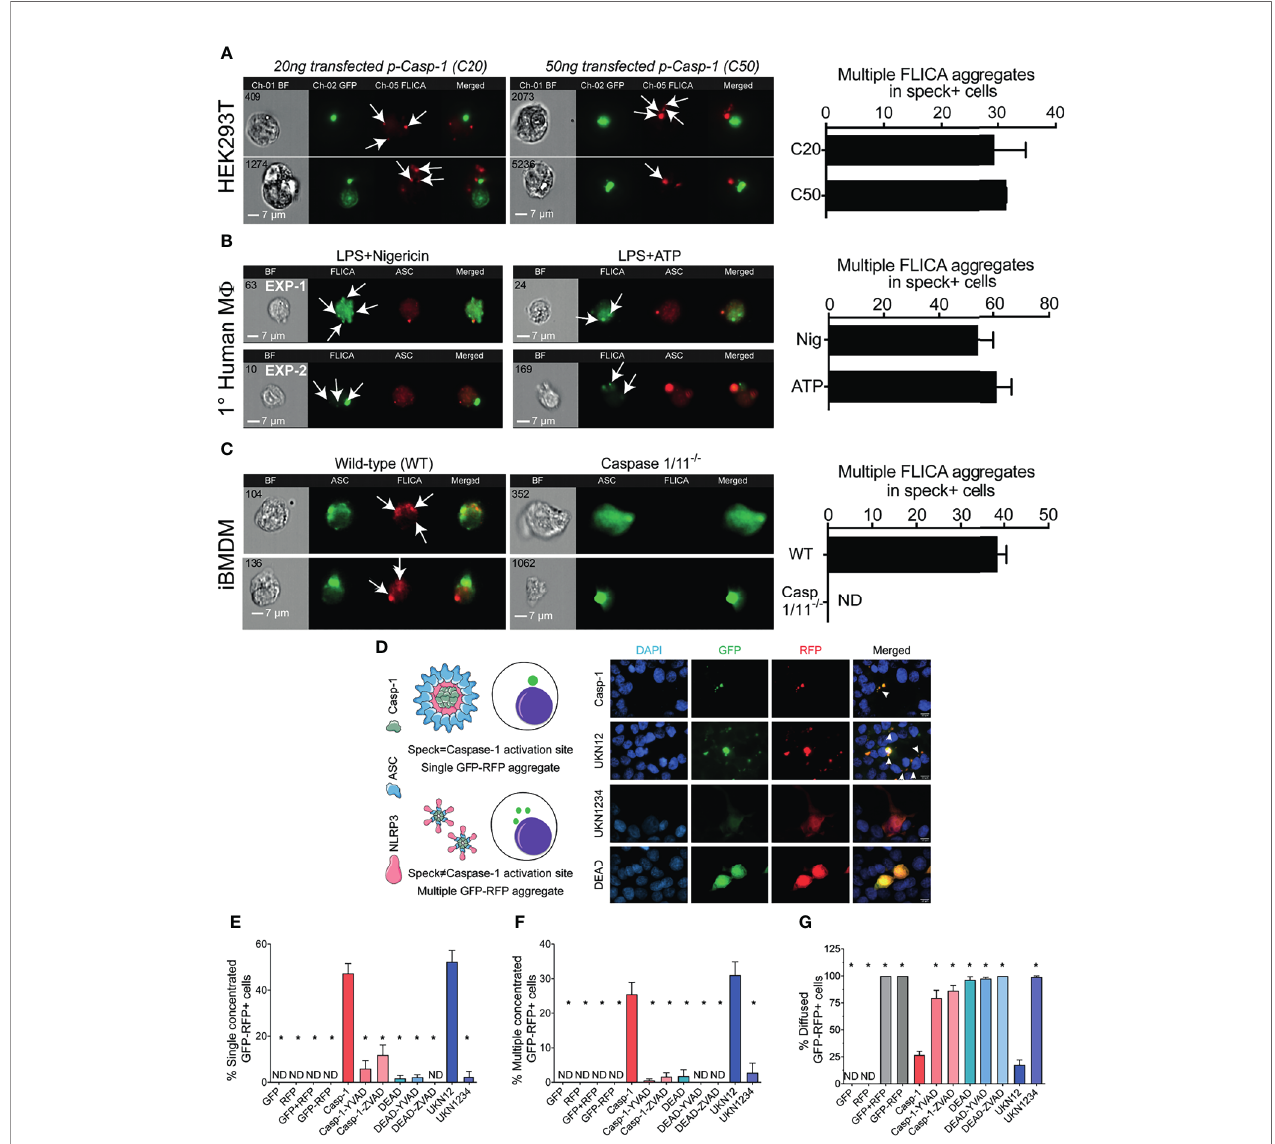
FIGURE 6 | NLRP3-dependent caspase-1 activity occurs at multiple cellular sites. LPS-primed primary human monocytes and immortalized BMDM cells were either left untreated or stimulated with 5 mM ATP or 10 µm nigericin for 30 min, stained with FLICA, and were fi xed and analyzed by ICCE. HEK293T cells were transfected with 50 ng GFP-ASC with or without 100 ng NLRP3 and stimulated with 5 m M nigericin. Following nigericin stimulation, cells were stained with FLICA, fi xed, and analyzed by ICCE. (A) (Left) The ASC (green) speck+ cells containing active caspase-1 (red) showed multiple FLICA (active caspase-1) aggregates in both cells transfected with 20 and 50 ng of CASP1. (Right) The frequency of cells containing speck and multiple FLICA aggregates. Data represented as mean ± SEM. (B) (Left) Primary human macrophages containing ASC speck (red) showing FLICA staining for active caspase-1 (green) as diffused and/or aggregated (multiple and distant from the speck). Representative images from two independent experiments are shown. (Right) The frequency of speck+ cells containing multiple FLICA aggregates. Data represented as mean ± SEM. (C) (Left) Immortalized BMDMs containing ASC speck (green) showing FLICA staining for active caspase-1 (red) as diffused and/or distant aggregates from ASC speck. Caspase-1/ 11 − / − BMDMs show no FLICA staining showing speci fi city of staining. (Right) The frequency of cells containing speck and multiple FLICA aggregates. Data represented as mean ± SEM. (D – G) HEK293T cells were transfected with 100 ng myc-ASC, 100 ng NLRP3, 400 ng CASP1 (WT or mutant), and 400 ng GFP-YVAD-RFP. Eighteen hours post-transfection, cells were fi xed and analyzed for GFP-RFP aggregates by microscopy. (D) Schematic diagram showing expected outcomes with bi fl uorescent reporter if single/multiple sites of active caspase-1 are present. Representative micrographs showing distribution of active caspase-1 sites in a cell; DAPI (blue), GFP (green), RFP (red), and merged. White arrows show cells with multiple GFP-RFP aggregates. (E) Frequency of cells containing single concentrated GFP-RFP aggregates. (F) Frequency of cells containing multiple concentrated GFP-RFP aggregates. (G) Frequency of cells containing diffused GFP-RFP. Data represented as mean ± SEM for each fi eld of view for at least three independent experiments. A minimum of 1,000 cells were analyzed for each condition. * p < 0.0001, for comparison with casp-1-transfected sample, one-way ANOVA followed by Dunnett ’ s multiple comparison tests. ND, not